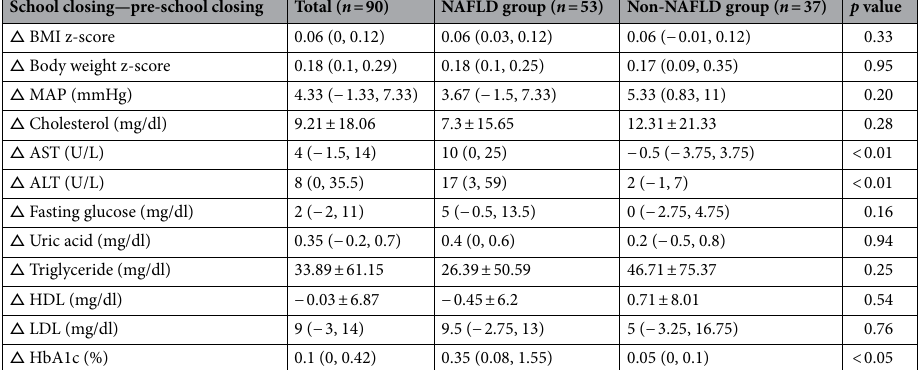
Table 4. Comparison of difference in each variable at pre-school closing and during school closing according to the presence of NAFLD. delta, △ Subtracting the value of the pre-social distancing from the value of the social distancing period, BMI body mass index, NAFLD non-alcoholic fatty liver disease, MAP mean arterial pressure, AST aspartate transferase, ALT alanine transferase, HDL high-density lipoprotein, LDL low-density lipoprotein, HbA1c hemoglobin